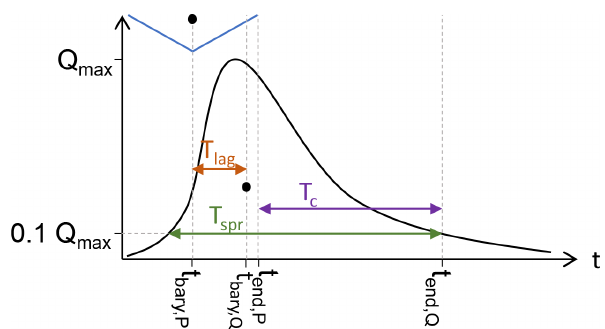
Figure 3. Scheme of the calculation of characteristic times T lag , T c , and T spr that were calculated using the simulated liquid and solid discharges. The points represent the barycenter of the hyetograph (blue curve) and of the fraction of discharge above the threshold of 0 . 1 Q max (black